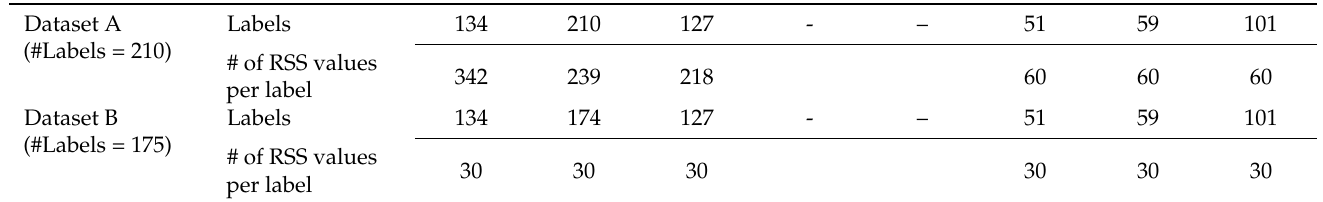
Table 6. Distributions of Wi-Fi received signal strength’s per